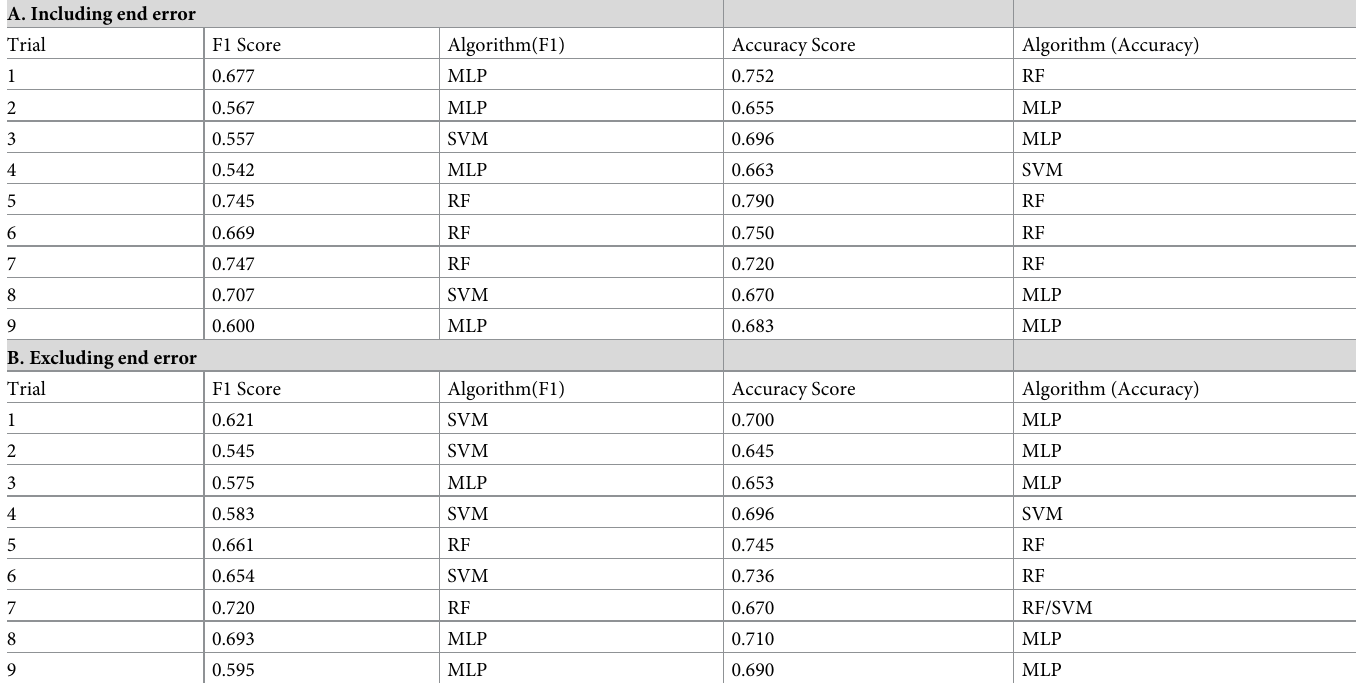
Table 4. Machine learning F1 and accuracy